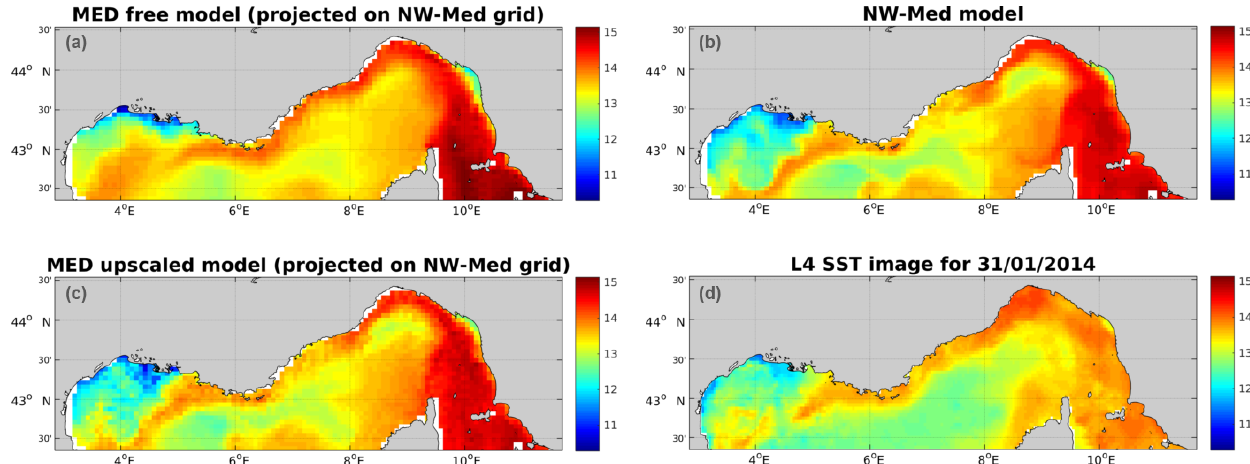
Figure 5. Sea surface temperature after the first upscaling step (31 January 2014) in the free model (a) , nested model (b) , upscaled model (c) and L4 satellite observation (d) .